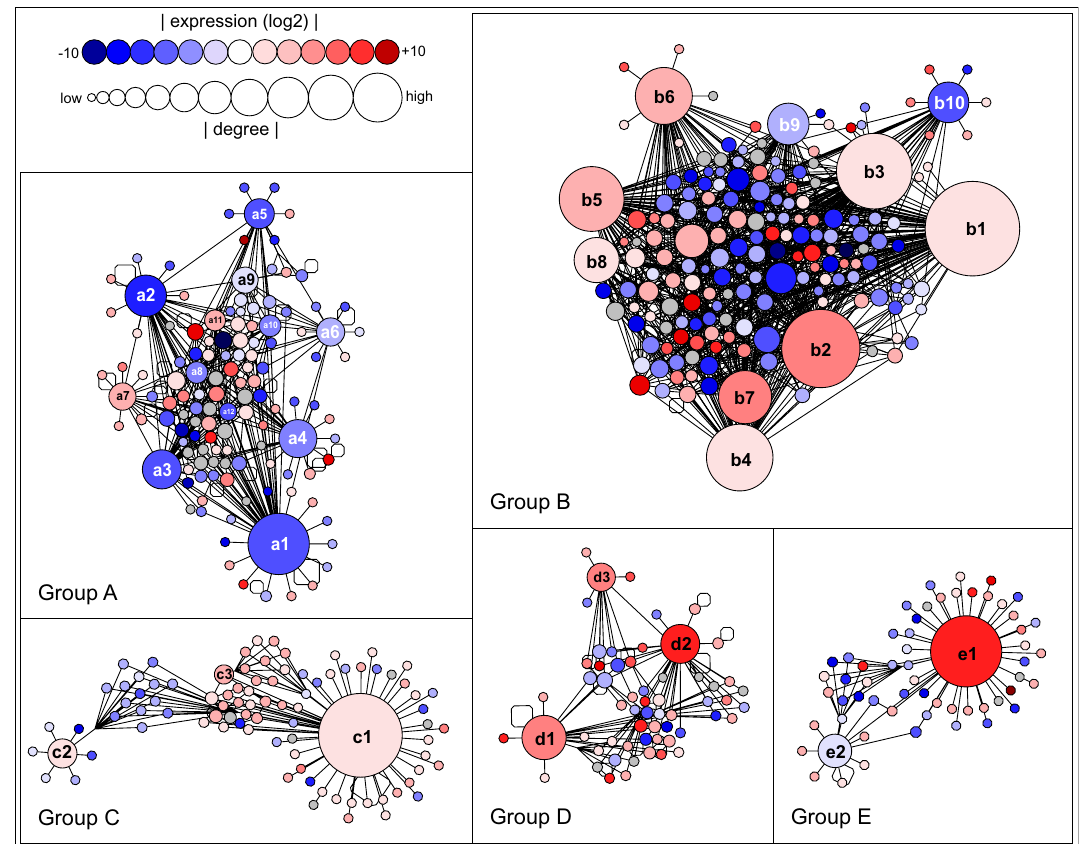
Figure 8. Predicted interactions between pepper proteins. Arabidopsis entries of the BioGRID 98 protein– protein interaction database were adapted to pepper proteins based on their strong homology. The five separate group of graphs contain 507 proteins (nodes) with 1364 interactions (edges). Nodes with at least ten connections are labelled, namely ( Group A) ; ( a1) CaTCP14 /XP_016578353, ( a2) CaTCP15/XP_016546616, ( a3) CaTCP4/XP_016541752, ( a4) CaTPR1/XP_016562946, ( a5) CaGAI/XP_016572500, ( a6) CaBRZ1/ XP_016568620, ( a7) CaGIF1/XP_016572280, ( a8) CaTCP21/XP_016564270, ( a9) CaGAI1/XP_016562448, ( a10) CaTCP8/XP_016539042, ( a11) CaRLT1/XP_016550332, ( a12) CaRBCMT/ XP_016548471. (